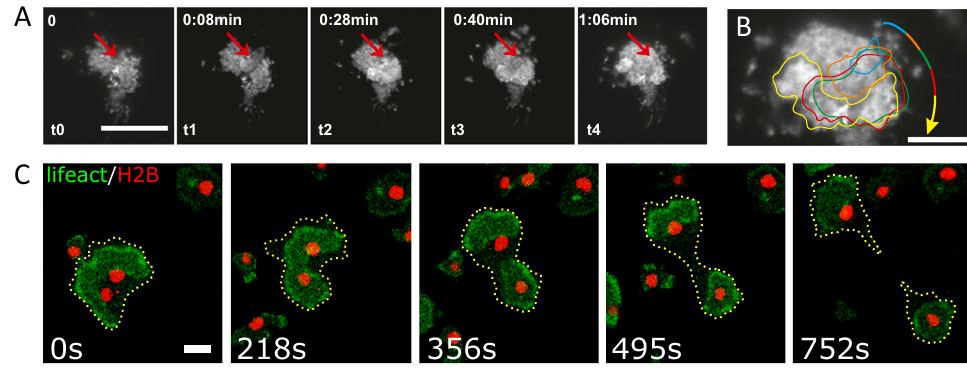
Figure 1. Examples of intracellular actin waves. ( A ) Actin wave nucleation and propagation in a migrating immature dendritic cell. Red arrows indicate the origin of the wave, scale bar 20 µ m. ( B ) Overlay of contours of representative actin waves shown in panel ( A ) during propagation. ( C ) Wave-mediated binary cytofission in a Dictyostelium discoideum cell, scale bar 10 µ m. An actin wave in a cell with two nuclei becomes unstable and splits into two independent segments that move in opposite directions and induce a cytofission event. Panels ( A ) and ( B ) are reproduced from [50] and panel ( C ) is reproduced from [53]. Copyright 2020 National Academy of Fig. 6. Actin wave nucleation and propagation in migrating immature DCs. ( A ) Representative epifluorescence image sequences of actin wave formation andprogressioninanimmatureDC.Redarrows indicate originofthewave.TIRF imagesofLifeact-GFPwereacquired every2s.(Scalebar,20 μ m.)( B )Overlay ofcellularoutlineof2representativeconsecutiveimagesdisplayedin A ,illustratingtheactinwaveprogression.Redindicatesinitialtime t ;greenindicates t + 1. Fig. 4. Wave-mediated binary cytofission. ( A ) Probability of a cytofission event to happen within the first 16 min of a simulation, depending on the cell The last image of the sequence is the overlay of t 0 (red) and t 4 (green).( C , Left ) Representative waveanalysis of wavefrom fluorescence TIRF imagesof Lifeact- size. The areas of simulated cells are multiples of a reference cell size of 113 µ m 2 , given by a disc of 12 µ m in diameter. For each cell size 40 independent GFP in the cell shown in A at t 4. Red and green lines show the location along which the kymograph was generated (top left to bottom right). ( C , Center and simulations with ↵ = 1, b = 0.05, p = 0.25, and u 0 = 1 were analyzed. Error bars represent the SD and are calculated assuming a binomial distribution. Right ) Representative kymographs of wave propagation. Arrows indicate wave front. (Scale bars, 1 μ m [length]; 10 s [time].) ( D ) Mean actin wave speeds ( B ) Simulation of a cell with an area of 339 µ m 2 and the same parameter values used in A . The wave splits into two parts and leads to cytofission. obtained for 4 representative individual cells. Number of waves analyzed per cell: 11 (cell 1), 13 (cell 2), 4 (cell 3), and 8 (cell 4). Box plot displays mean speed ( C ) Size evolution of a growing cell over time in a numerical simulation (corresponding to Movie S17). Once a critical size of about four to five times the (middle line) and SEM (box). ( E ) Contours of representative actin wave shown in A during propagation. size of a single cell is reached, the cell divides via wave-mediated fission into 2 cells of at least the size of a single cell. The graph shows only the size of the Stankevicinsetal. larger daughter cells over eight generations. ( D ) Analysis of the probability of wave-mediated cytofission within the first 16 min of observation for fused DdB NF1 KO cells of different sizes. Cells were categorized according to their area into four groups: < 250 µ m 2 (10 cells), 250 to 500 µ m 2 (21 cells), 500 to 2 (5 cells), and 750 to 1,000 µ m 2 (5 cells). ( E ) The actin wave in a fused DdB NF1 knockout cell with two nuclei expressing Lifeact-GFP and histone 750 µ m H2B-RFP becomes unstable and splits into two independent waves that move in opposite directions and induce cytofission. ( F ) Histogram of the number of nuclei in 55 cytofission fragments obtained from live cell imaging experiments with DdB NF1 knockout cells expressing Lifeact-GFP and histone H2B-RFP. ( G ) Schematic of wave-mediated binary cytofission in a growing cell. A min is the minimal cell area and A crit the critical cell size where wave-mediated cytofission starts to occur. (Scale bars, 10 µ m.)